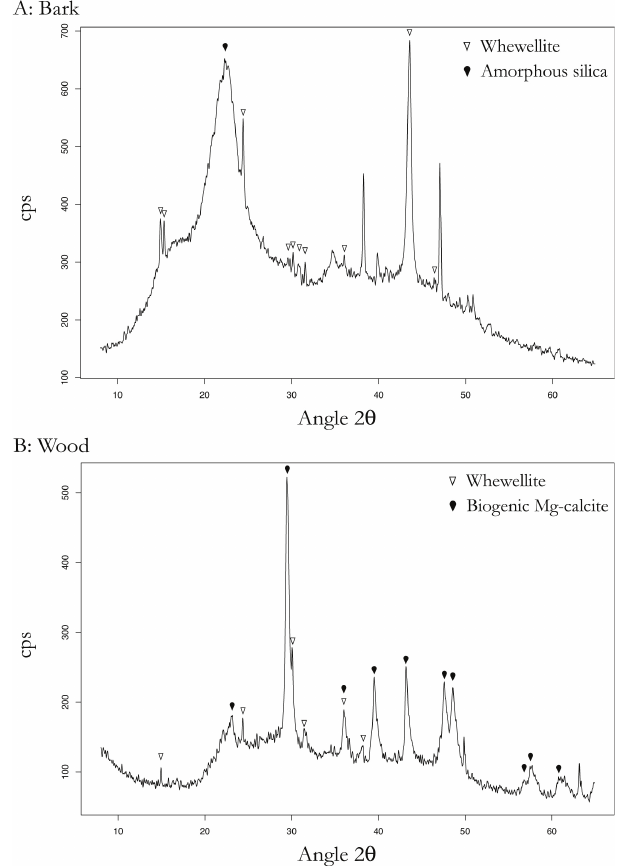
Fig. 2. (a) X-ray diffractogram of a partially mineralized iroko bark showing the presence of whewellite (calcium oxalate monohydrate) and amorphous silica. (b) X-ray diffractogram of partially miner- alized iroko wood tissues showing the presence of whewellite (cal- cium oxalate monohydrate) and biogenic Mg-calcite (High Magne- sium Calcite). cps: counts per second; Angle 2 θ : Bragg angle, angle between the incident and diffracted X-ray